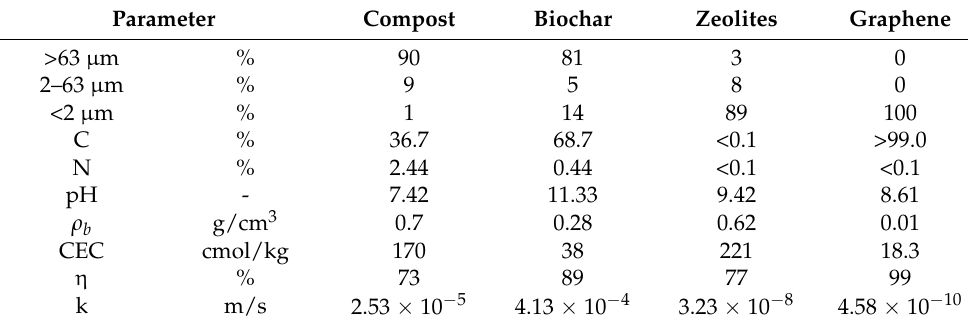
Table 2. Characteristics of the four soil conditioners used in this